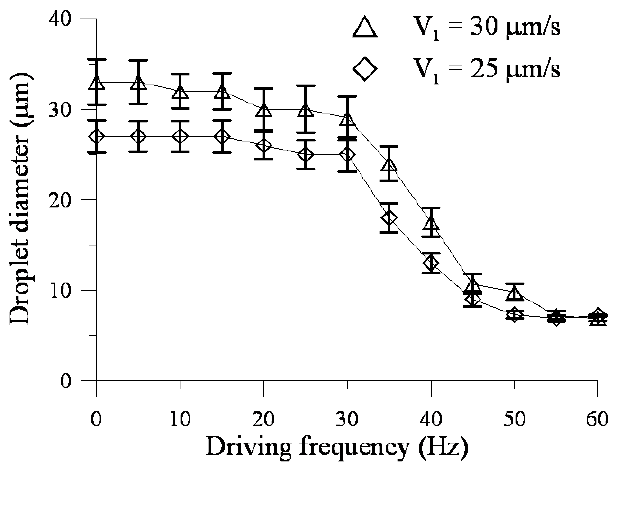
Figure 8. The relationship between the average diameter of the droplets and the driving frequency of the EMV at an applied absolute pressure of 10.4 psi. The V the V are 30 μm/s and 25 μm/s, 1